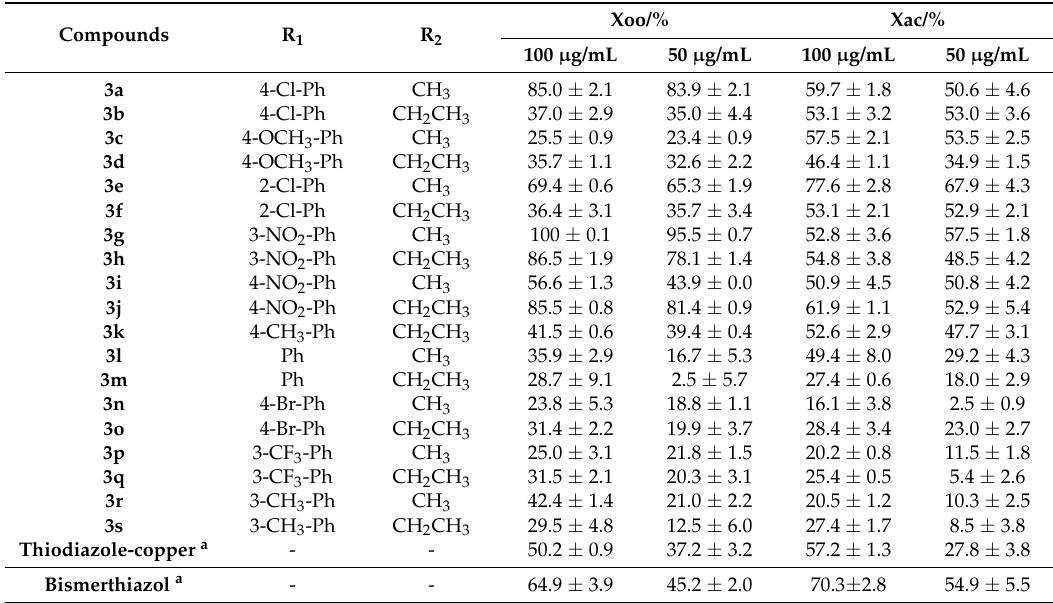
Table 1. Antibacterial activities of target compounds ( 3a–3s ) against plant pathogens Xanthomonas oryzae pv. oryzae (Xoo) and Xanthomonas axonopodis pv. citri (Xac) in vitro. Compounds